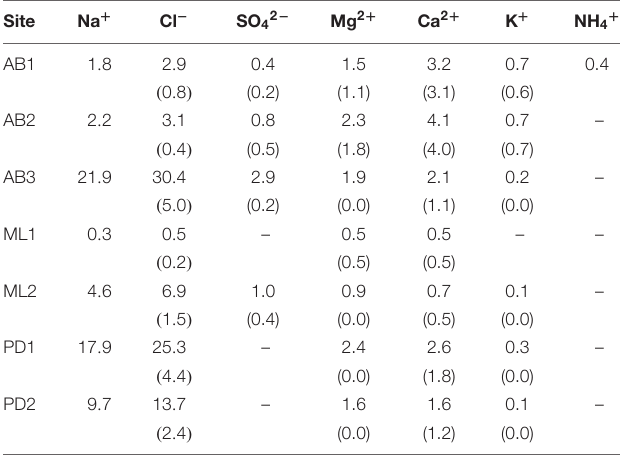
TABLE 1 | Mean soluble ion concentrations ( µ Eq L − 1 ) in surface meltwater on the Svalbard glaciers.